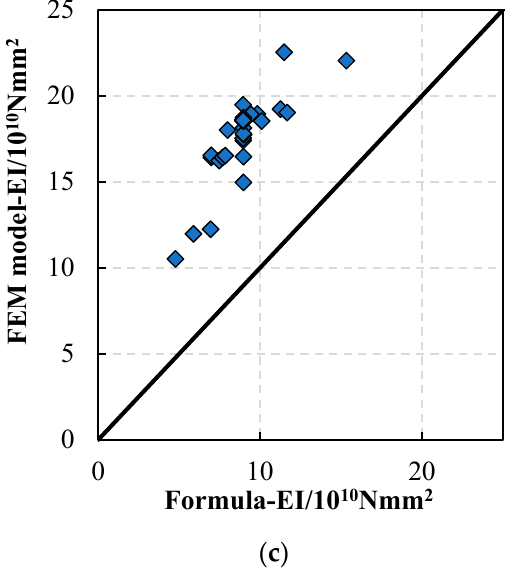
Figure 18. Comparison between the formula results and the numerical model results: ( a ) compression stiffness; ( b ) tension stiffness; ( c ) bending stiffness.